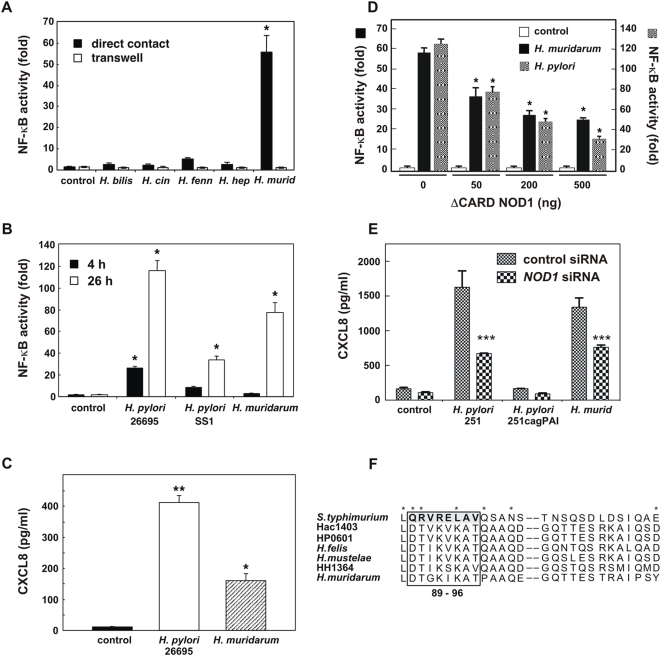

H. muridarum induces NOD1 responses in HEK293 and AGS cells.(A) NF-κB-dependent luciferase reporter activity was measured in HEK293 cells that had been incubated for 24 h in direct contact, or separated by a transwell filter membrane, from the following bacteria: H. bilis ATCC51630, H. cinaedi ATCC35683 (H. cin), H. fennelliae ATCC35684 (H. fenn), H. hepaticus ATCC51448 (H. hep), or H. muridarum ATCC49282 (H. murid). Control cells were transfected with the pCDNA3 vector. (B) NF-κB reporter activity in HE293 cells that had been incubated in direct contact for 4 h or 26 h with H. pylori (strains 26695 or SS1) or H. muridarum ATCC49282 bacteria. Control cells were transfected with the pCDNA3 vector. (C) CXCL8 secretion in culture supernatants of HEK293 cells at 24 h post-stimulation with H. muridarum ATCC49282 or H. pylori 26695. Control cells were left unstimulated. (D) HEK293 cells were co-transfected with the Igk-luc reporter plasmid and increasing amounts (in ng) of a NOD1 dominant-negative construct (ΔCARD NOD1), then either left untreated (control) or stimulated for 24 h with H. muridarum ATCC49282 or H. pylori 26695 bacteria. The total quantity of DNA was standardized throughout using pCDNA3 alone. (E) AGS cell lines stably expressing siRNA to an irrelevant gene (control siRNA) or to NOD1 (NOD1 siRNA) were either left untreated (control), or co-cultured for 1 h with H. pylori 251, 251 cagPAI (an isogenic mutant that lacks a functional T4SS) or H. muridarum ATCC49282. The medium was changed and the CXCL8 levels measured in supernatants at 24 h post-stimulation. NF-κB and CXCL8 data (triplicate determinations) are representative of 2–3 independent experiments. Statistical differences were observed for NF-κB reporter activity and CXCL8 responses in stimulated versus control cells (*, P<0.05; **, P<0.0001; ***, P = 0.002). (F) The amino acid sequence of a segment of H. muridarum ATCC49282 FlaA (Accession no. FM992115) was deduced by DNA sequencing and compared by CLUSTALW analysis to the corresponding regions of flagellin homologs from S. typhimurium
[29], Helicobacter acinonychis (Hac1403; Accession no. CAK00134), H. pylori (HP0601), Helicobacter felis (H. felis; Accession no. Q9XB38), Helicobacter mustelae (H. mustelae; Accession no. P50612) and H. hepaticus (HH1364). The H. pylori and H. hepaticus FlaA sequences can be accessed at http://cmr.jcvi.org/cgi-bin/CMR/CmrHomePage.cgi. The amino acid residues, corresponding to residues 89–96 of S. typhimurium FliC, which have been identified as being critical for TLR5 activation [29], are highlighted by a box. This region shares three amino acid residues with another series (shown by asterisks) that had previously been shown to be important for TLR5 signaling [31].